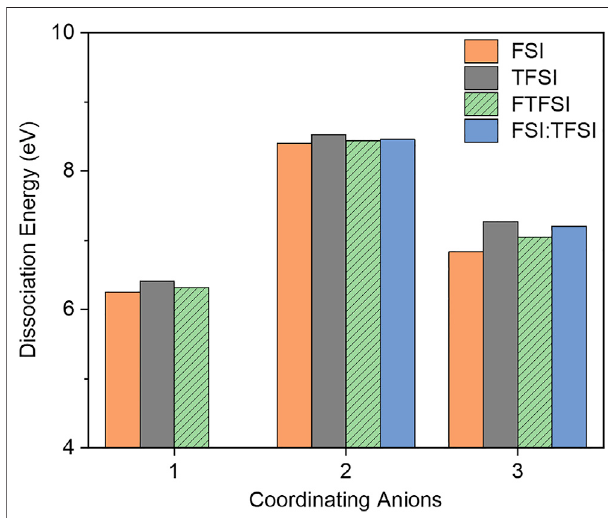
Figure 5 . Previously, the integral binding energy for Li solvates with two [TFSI] anions calculated at the DFT/6-311+(d) level of theory was reported as − 792.5 kJ/mol (8.2 eV) (Umebayashi et al., 2007), which is in reasonable agreement with our calculated Li [TFSI] 2 − 1 (middle structure in Figure 5 ) E D of 8.59 eV (828.8 kJ/ mol). For [DCA], there is Li + -N interaction via monodentate